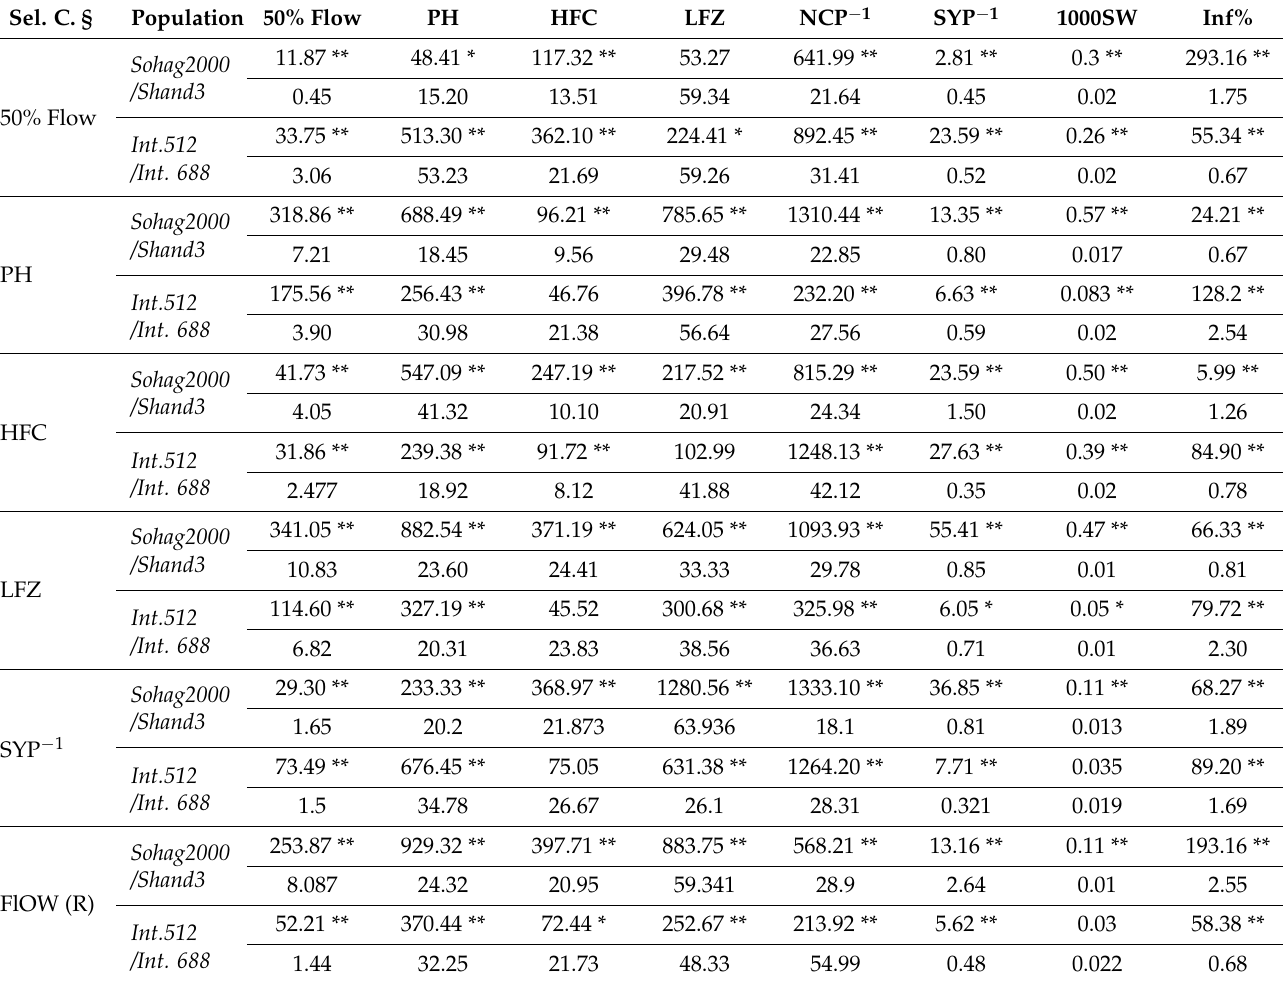
The entries mean squares (five selected families + two parents) were significant ( p ≤ 0.01) for all traits in both populations (Table 3). Table 3. Pertinent mean squares of the studied traits for the two populations in the F 4 - generation. Sel. C.